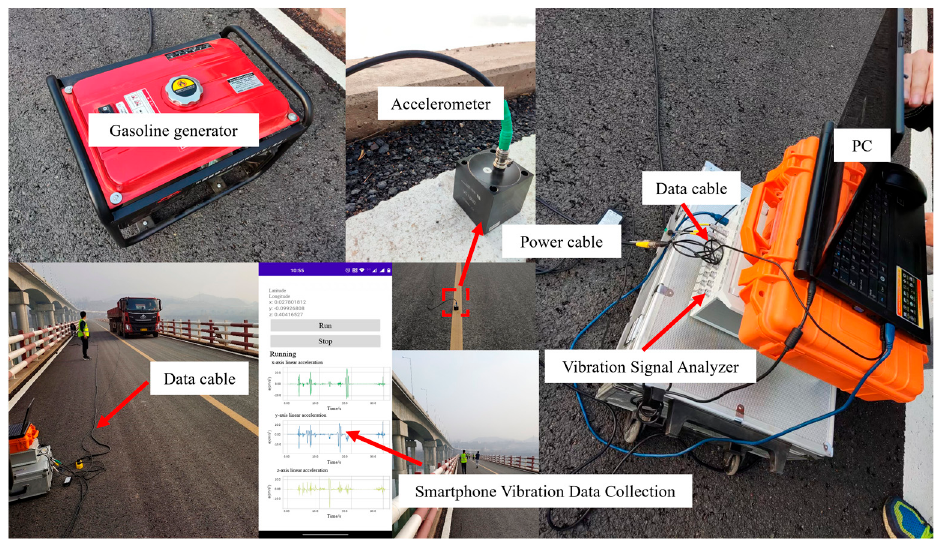
Figure 3. Experiment site layout.